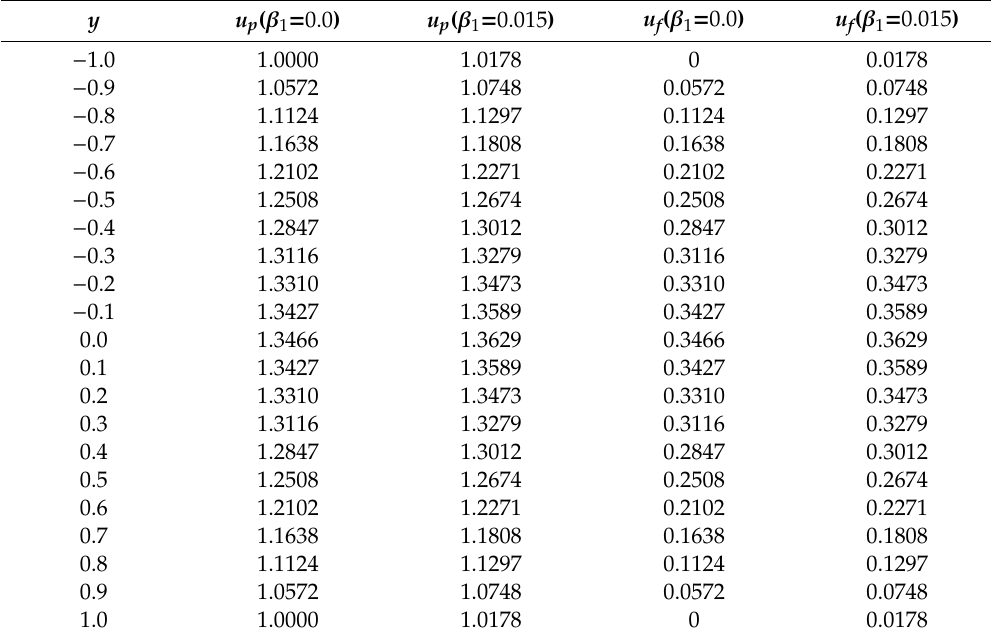
Table 1. Variation in the velocity of both phases against slip parameter.